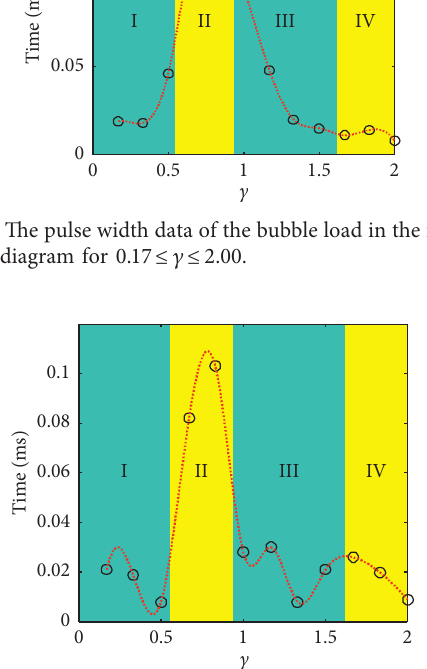
Figure 6: The pulse width data of the bubble load in the second cycle variation diagram for 0.17 ≤ c ≤ 2.00.